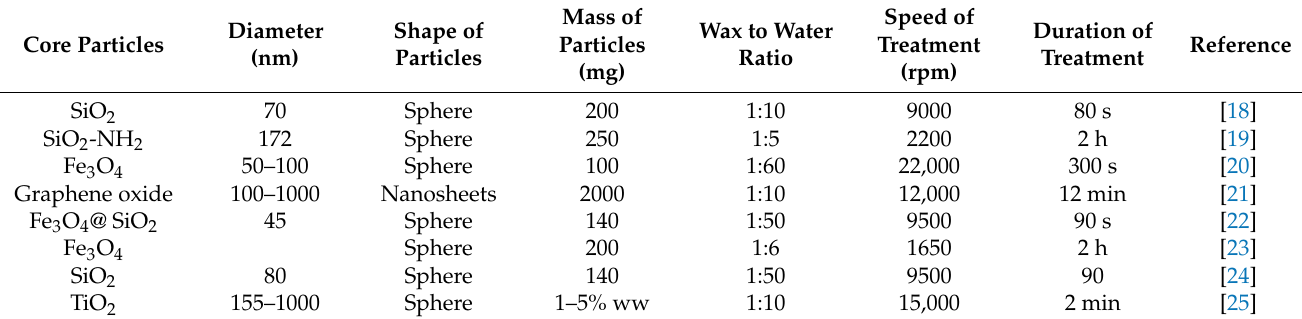
Table 1. Janus particles produced with Granick’s method and the main processing